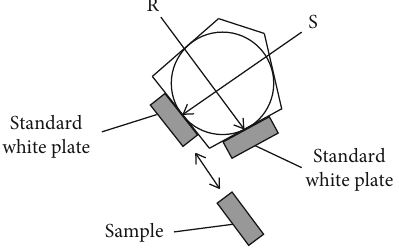
Figure 2: Setup for the measurement of di ff use re fl